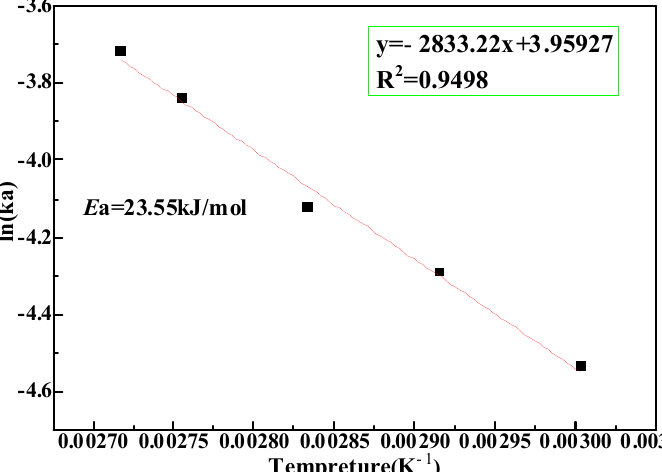
Figure 9. Plots of ln(Ka) versus temperature of leaching process. The correlation coefficient (R 2 ) was over 0.94 at different leaching temperatures. The apparent activation energy (Ea) of the leaching process was calculated as 23.55 kJ/mol.